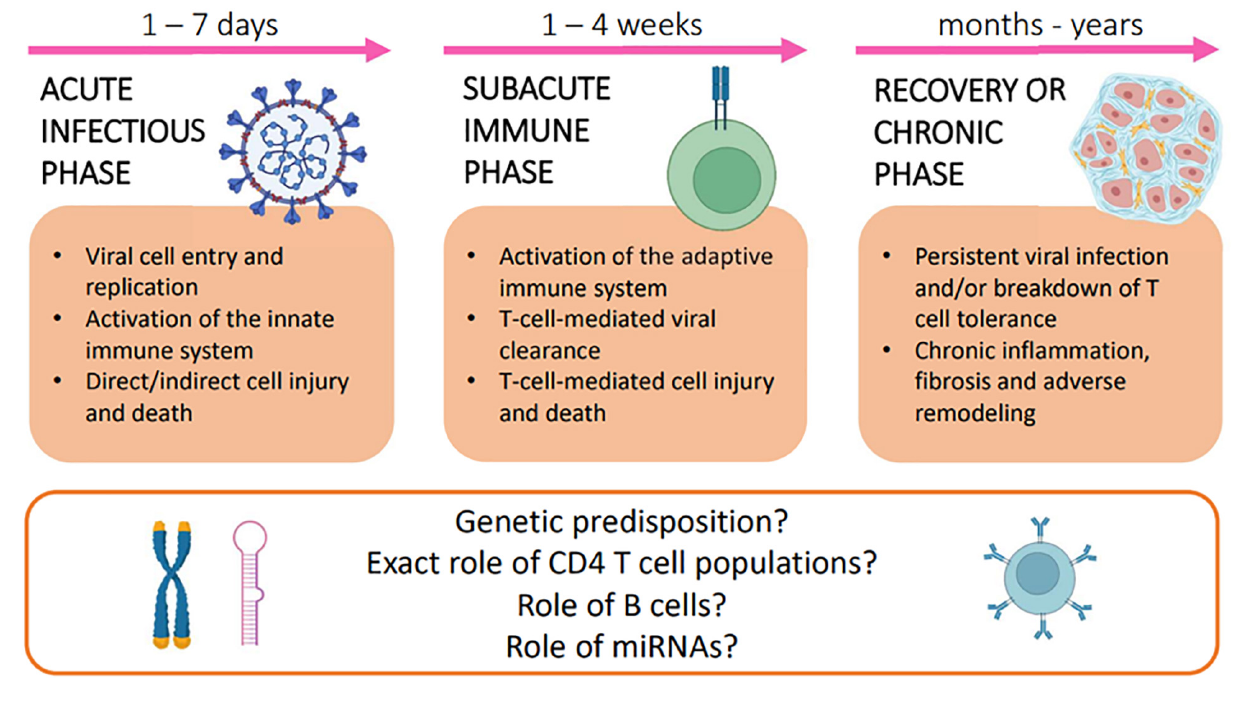
FIGURE 1 | Three-phase model for the pathogenesis of